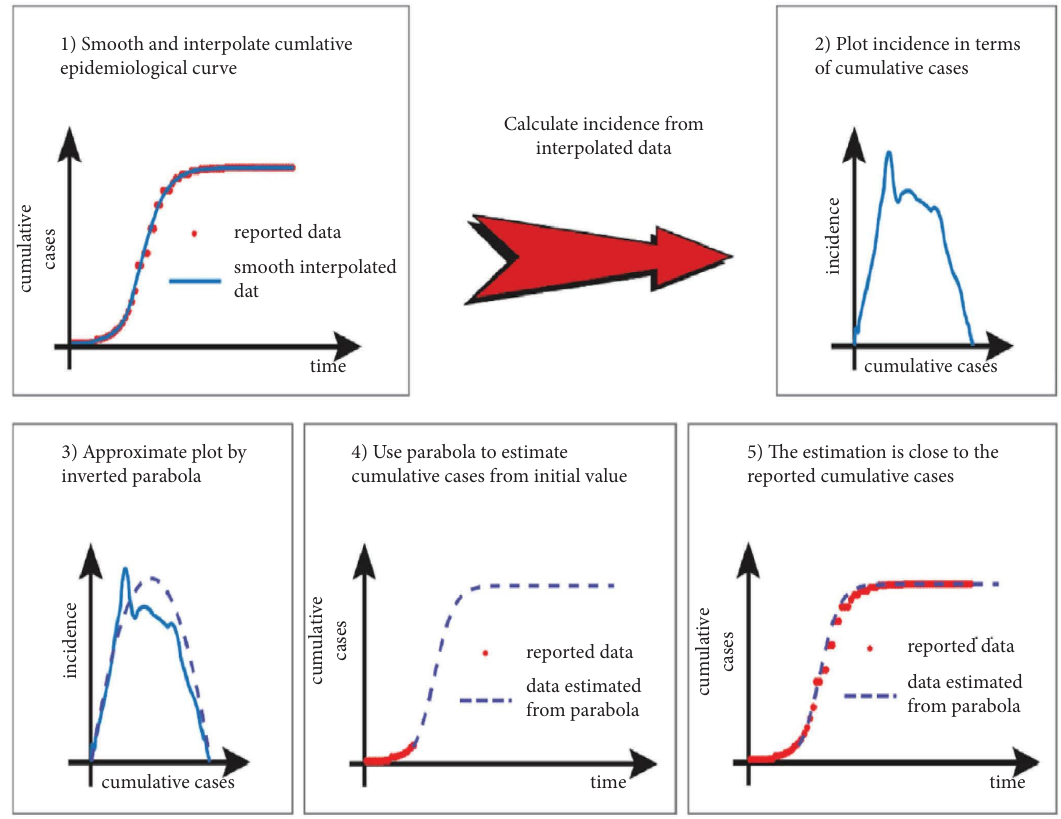
Figure 3: Methodology used by Lega and Brown